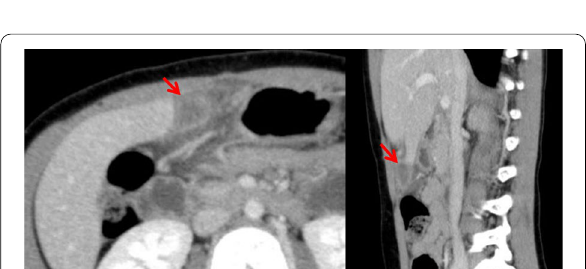
Fig. 2 Enhanced computed tomography scan of the